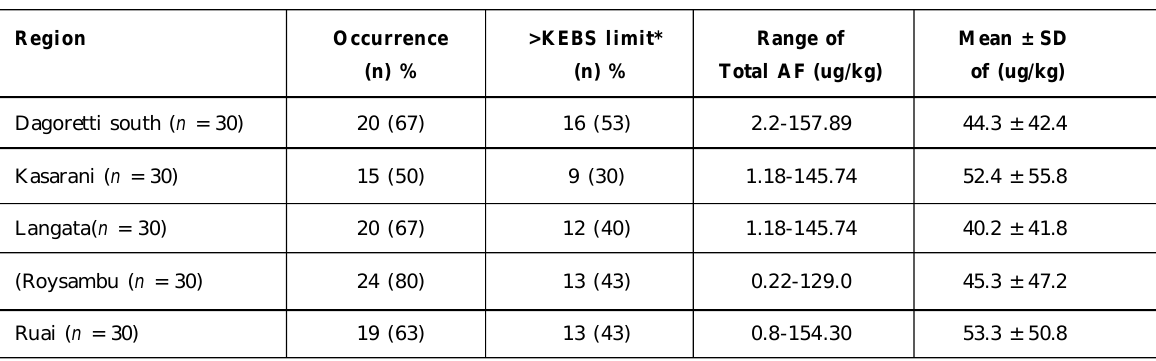
Table 3: Aflatoxin levels of layer feeds grouped by regions in Nairobi County, Kenya Region Occurrence >KEBS limit* Range of Mean ± SD (n) % Total AF